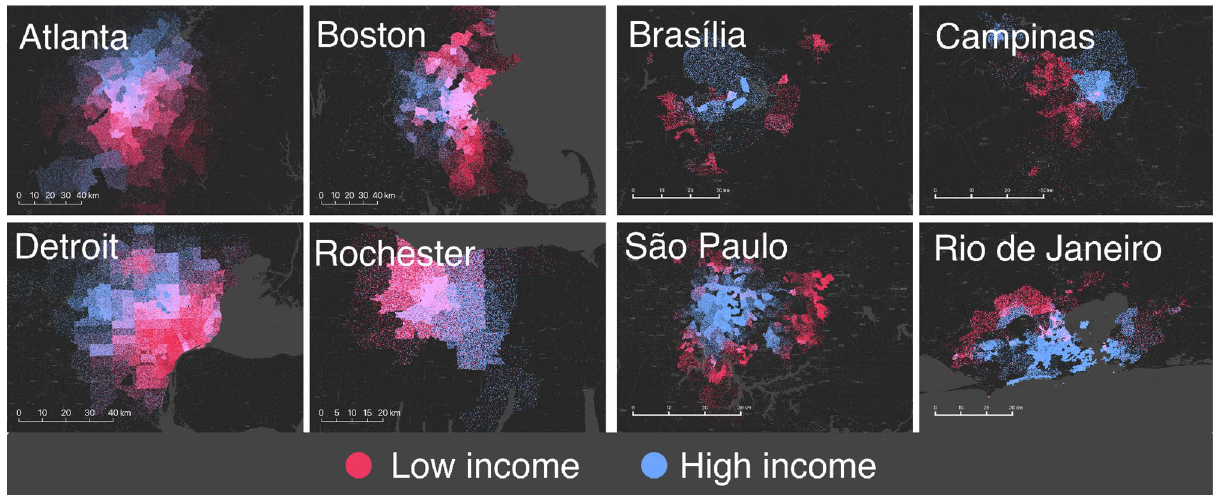
Figure 6. Socioeconomic in-flow heatmaps for selected cities in the US and Brazil. Colors represent the income level of the origin area that produced mobility flow into the plotted destination region. We see that cities such as Atlanta and Boston in the US experience considerable overlap between low and high income destinations, suggesting that income is not a defining factor in where people are able to live and go. In other cities like Detroit and Rochester, we see that the destinations of high and low income residents are relatively partitioned, suggesting that the particular land use decisions made in these cities have allowed lower income residents better access to amenities by living in the downtown areas. We see consistent separation between high and low income destinations in Brazil across all cities, suggesting that amenity access is generally shaped by residential